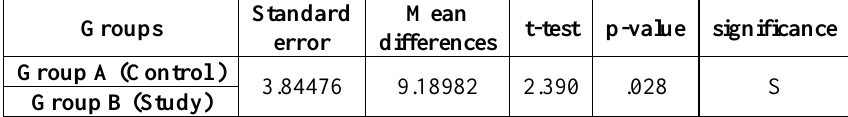
Table 4: t-test analysis of transverse strength test